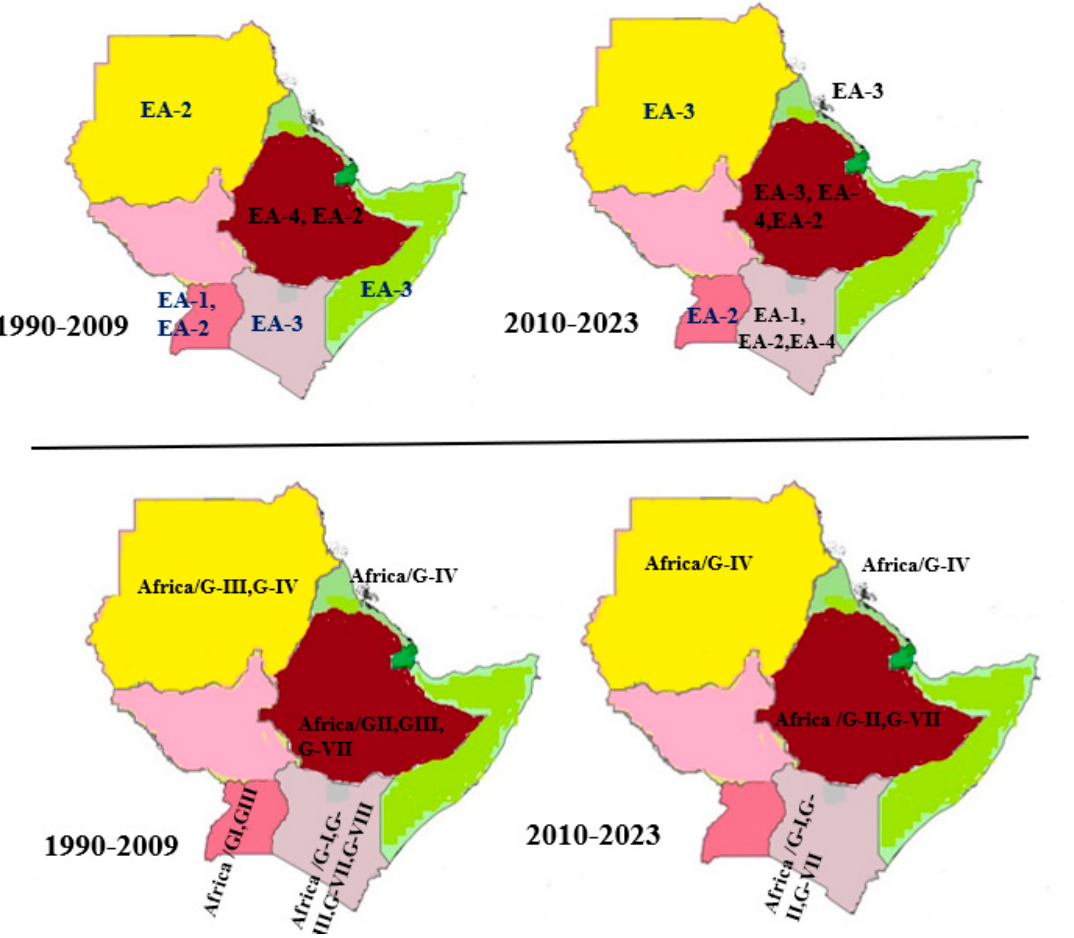
Figure 2. Serotype O ( top panel ) and A ( bottom panel ) topotype distribution and evolution in the Horn of Africa countries (1990–2023)